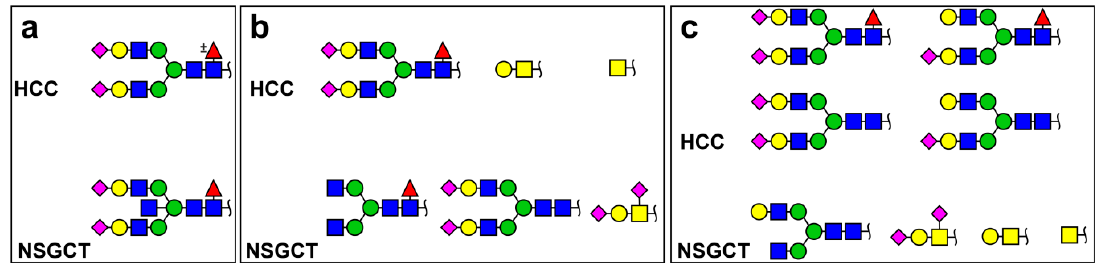
Figure 3. Typical glycan structures on α -fetoprotein (AFP) isolated from hepatocellular carcinoma (HCC) or NSGCT patients determined in various papers: ( a ) drawn according to information provided in ref. [112]; ( b ) Reprinted by permission from Nature, Copyright 1999 from ref. [113] and ( c ) Reprinted by permission from Nature, Copyright 2000 from ref. [114].